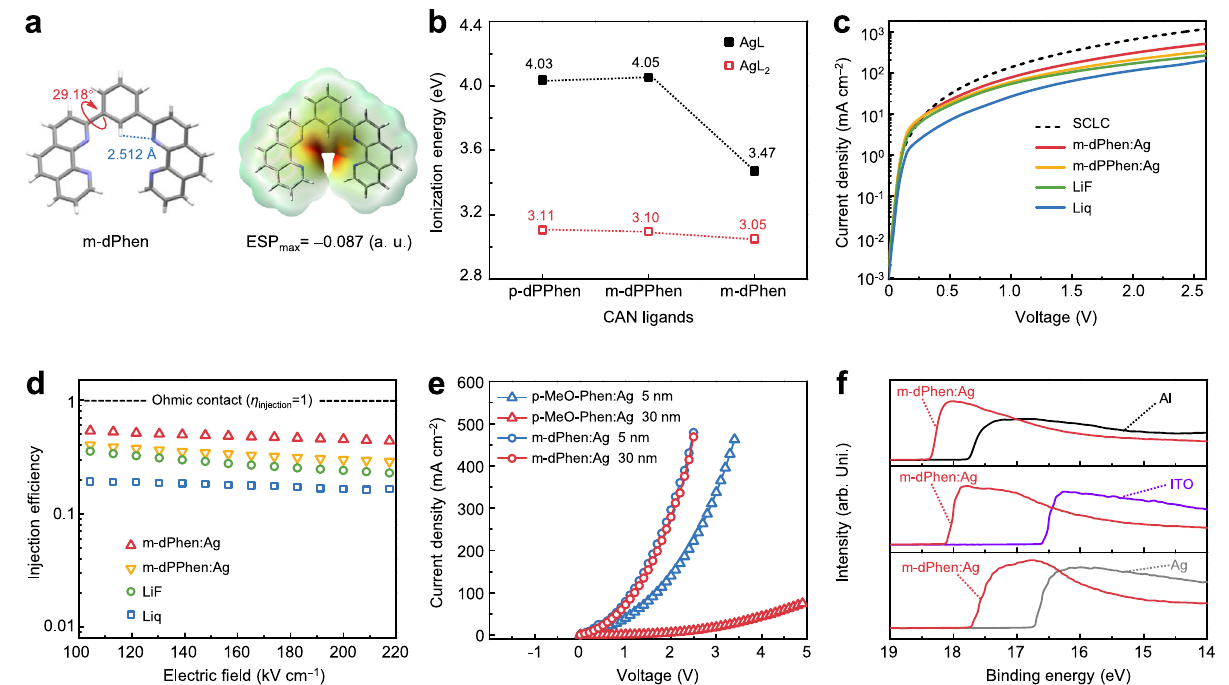
Fig. 4 Characterization of the electron injection properties of m-dPhen. a Single-crystal structures and ESP maps of m-dPhen. b Calculated ionization energies of different organometallic complexes consisting of diphenanthroline ligands and silver. c The current density ( J ) − voltage ( V ) characteristics of EODs based on different EILs of LiF (1 nm), Liq (1 nm), m-dPPhen:Ag (5 nm, 10 wt%), and m-dPhen (5 nm, 10 wt%). d The injection ef fi ciencies of EODs based on different EILs of LiF (1 nm), Liq (1 nm), m-dPPhen:Ag (5 nm, 10 wt%), and m-dPhen (5 nm, 10 wt%). e The J − V characteristics of EODs based on EILs of p-MeO-phen:Ag (5 or 30 nm, 10 wt%) and m-dPhen:Ag (5 or 30 nm, 10 wt%). f UPS analysis of different electrodes, including Al (10 nm), ITO (135 nm) and Ag (10 nm), with and without m-dPhen:Ag (5 nm, 10 wt%) being the best. At a high current density of 100 mA cm − 2 , the driving voltage of the EOD using m-dPhen:Ag was as low as 1.1 V, which is lower than those based on m-dPPhen:Ag (1.3 V),